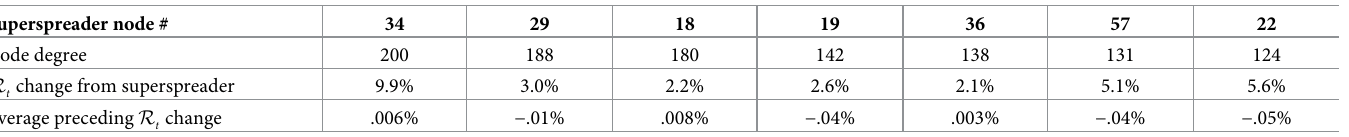
Table 2. Impact of superspreaders on the reproduction number R